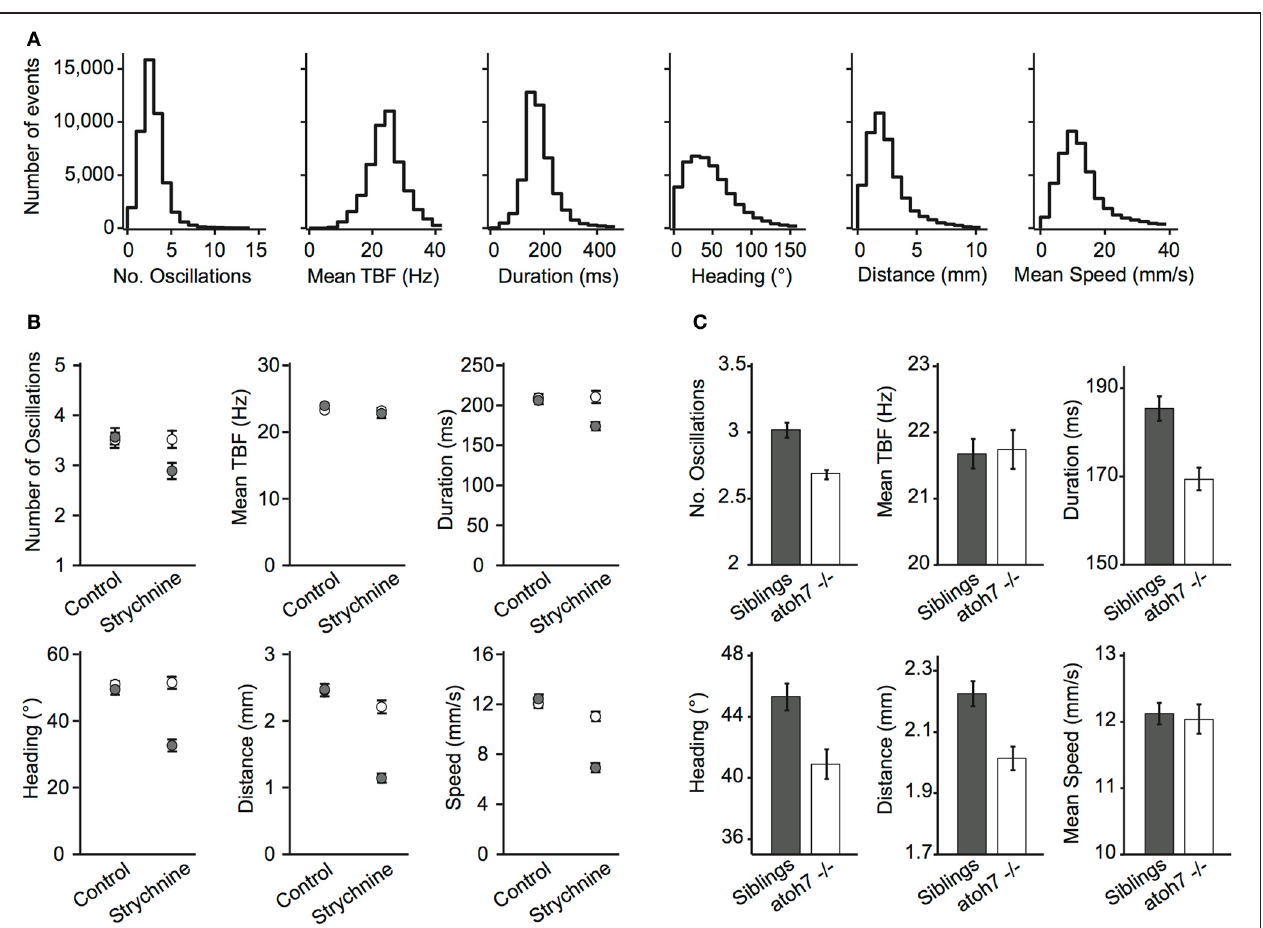
the glycinergic receptor antagonist strychnine on the global parameters of movements. White circles are before application, gray are after application (two videos, 42 larvae for each condition, two clutches, 6–7dpf, 10,459 movements). (C) Effect of the atoh7 mutation on the global parameters characterizing movements (four videos, 112 mutants atoh7 − / − , and 112 control siblings, four clutches, 6dpf). For (B,C) : error bars are standard errors of the mean and statistics were calculated per